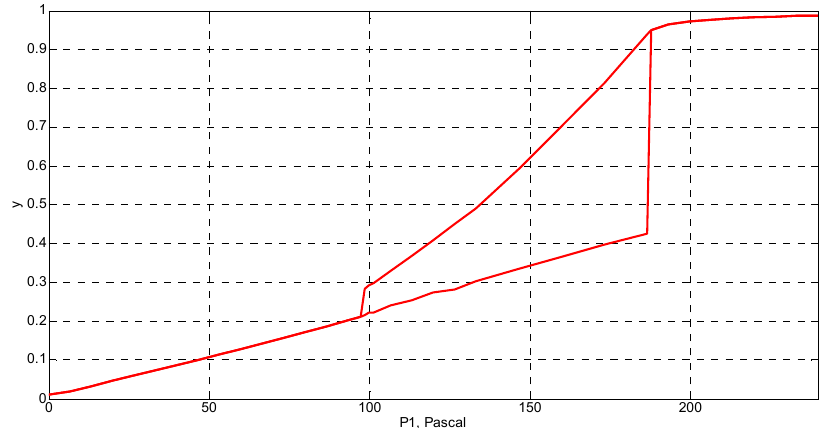
Figure 6. Amplitude values at stationary oxygen superficial fractional coverage versus carbon monoxide partial pressure [44].